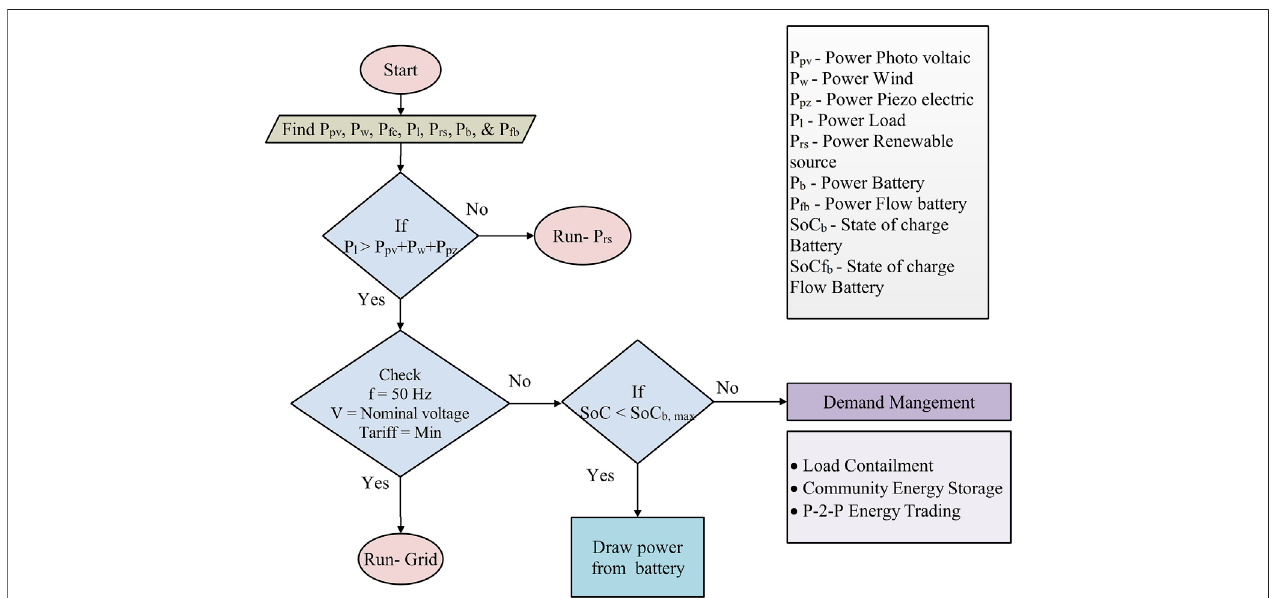
FIGURE 3 | Energy management fl ow